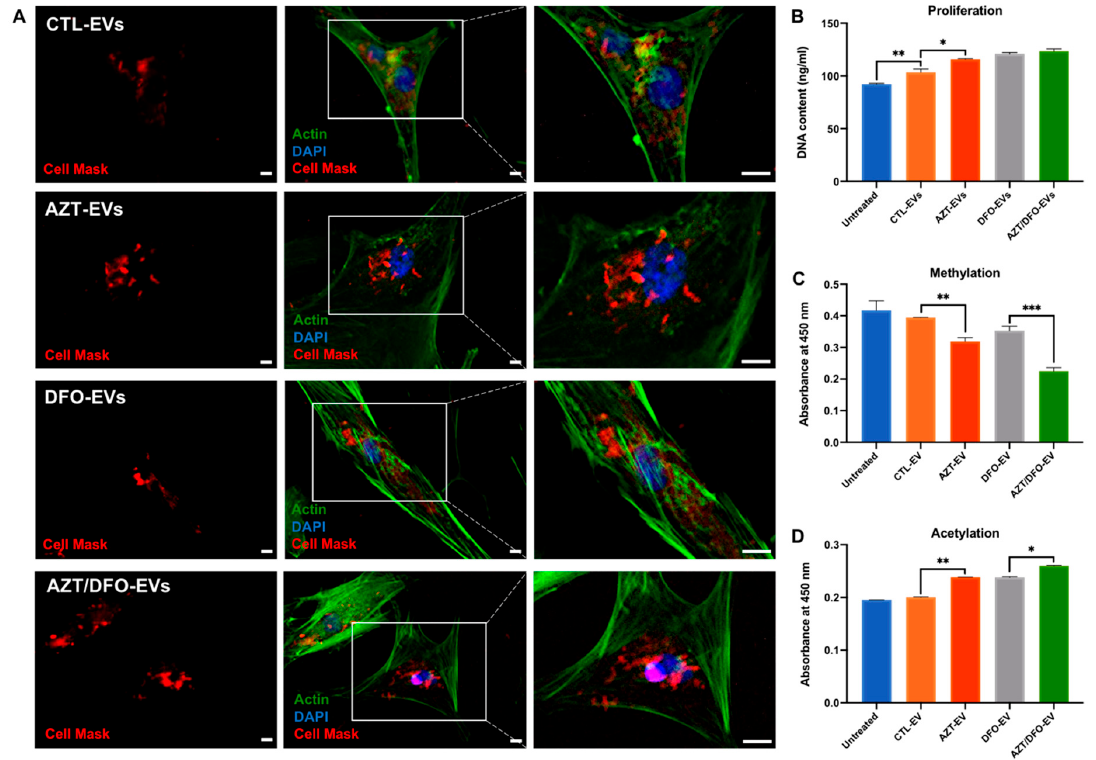
Figure 6. The e ff ects of AZT/DFO-EVs on the general behaviour of hBMSCs. ( A ) EV cell uptake in hBMSCs following 16 h incubation. ( B ) Proliferation of hBMSCs treated with EVs after 7 days of basal culture. ( C ) Histone methylation levels of EV-treated hBMSCs after 3 days basal culture. ( D ) Histone acetylation levels of EV-treated hBMSCs after 3 days basal culture. Data are expressed as mean ± SD ( n = 3). * p ≤ 0.05, ** p ≤ 0.01 and *** p ≤ 0.001. Scale bar = 100 µm.